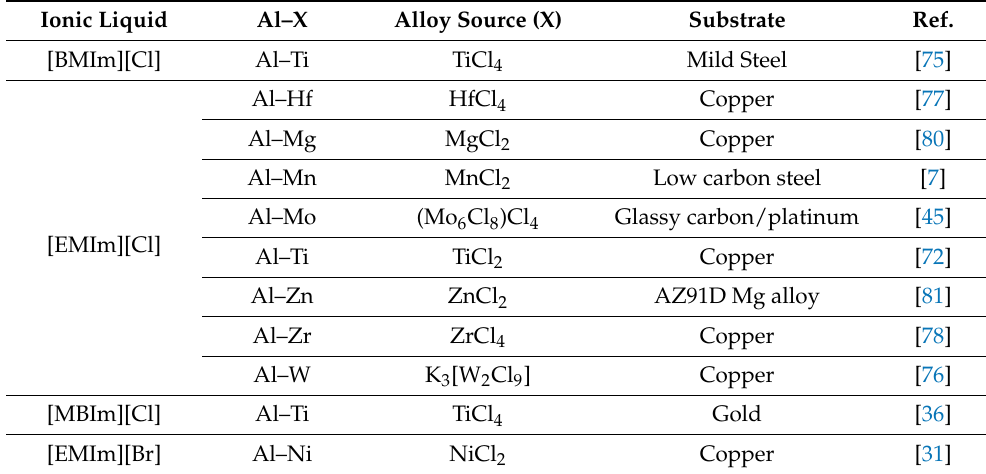
Table 7. Table showing the list of Al-X alloys studied employing different ionic liquid